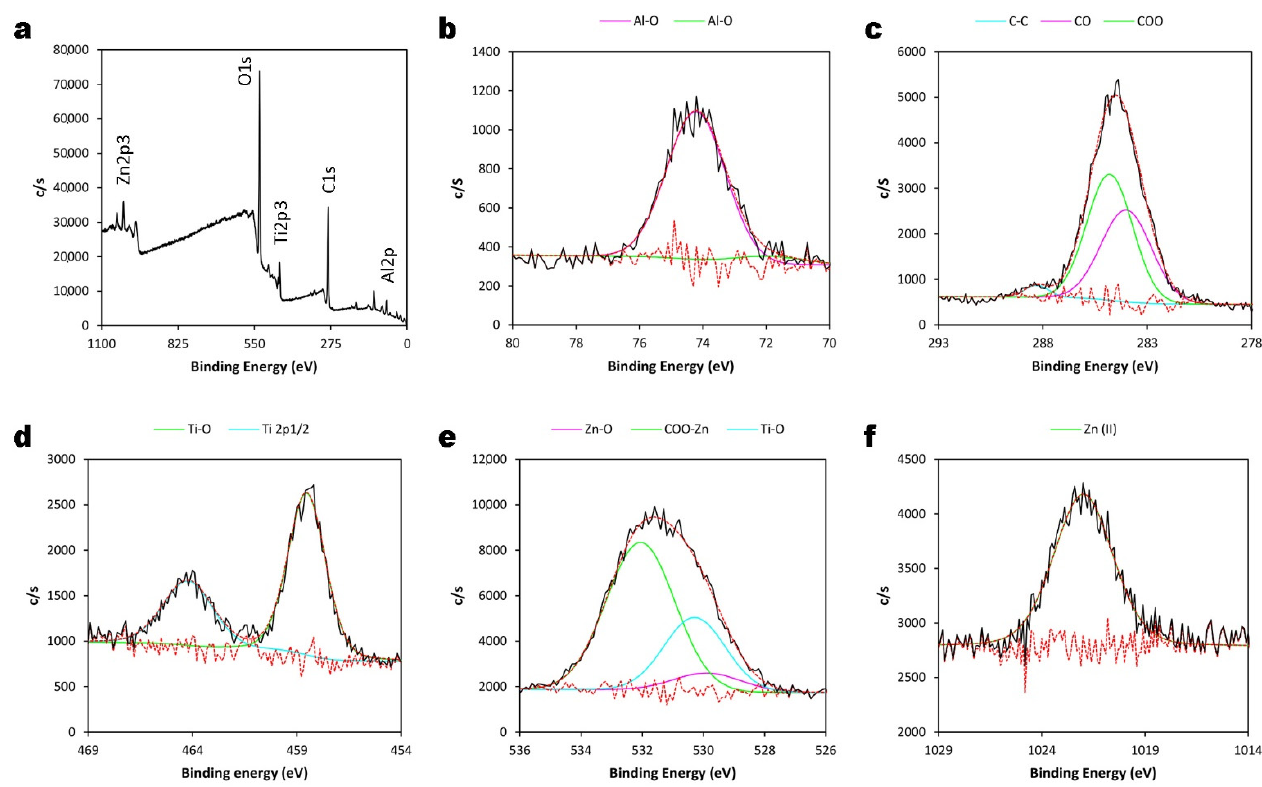
Figure 4. ( a ) General XPS spectrum of the superhydrophobic surface. The HR-XPS spectra of ( b ) Al-2p, ( c ) C-1s, ( d ) Ti-2p, ( e ) O-1s, and ( f ) Zn-2p, revealing the presence of zinc laurate as the main compound of the coating as well as the presence of TiO 2